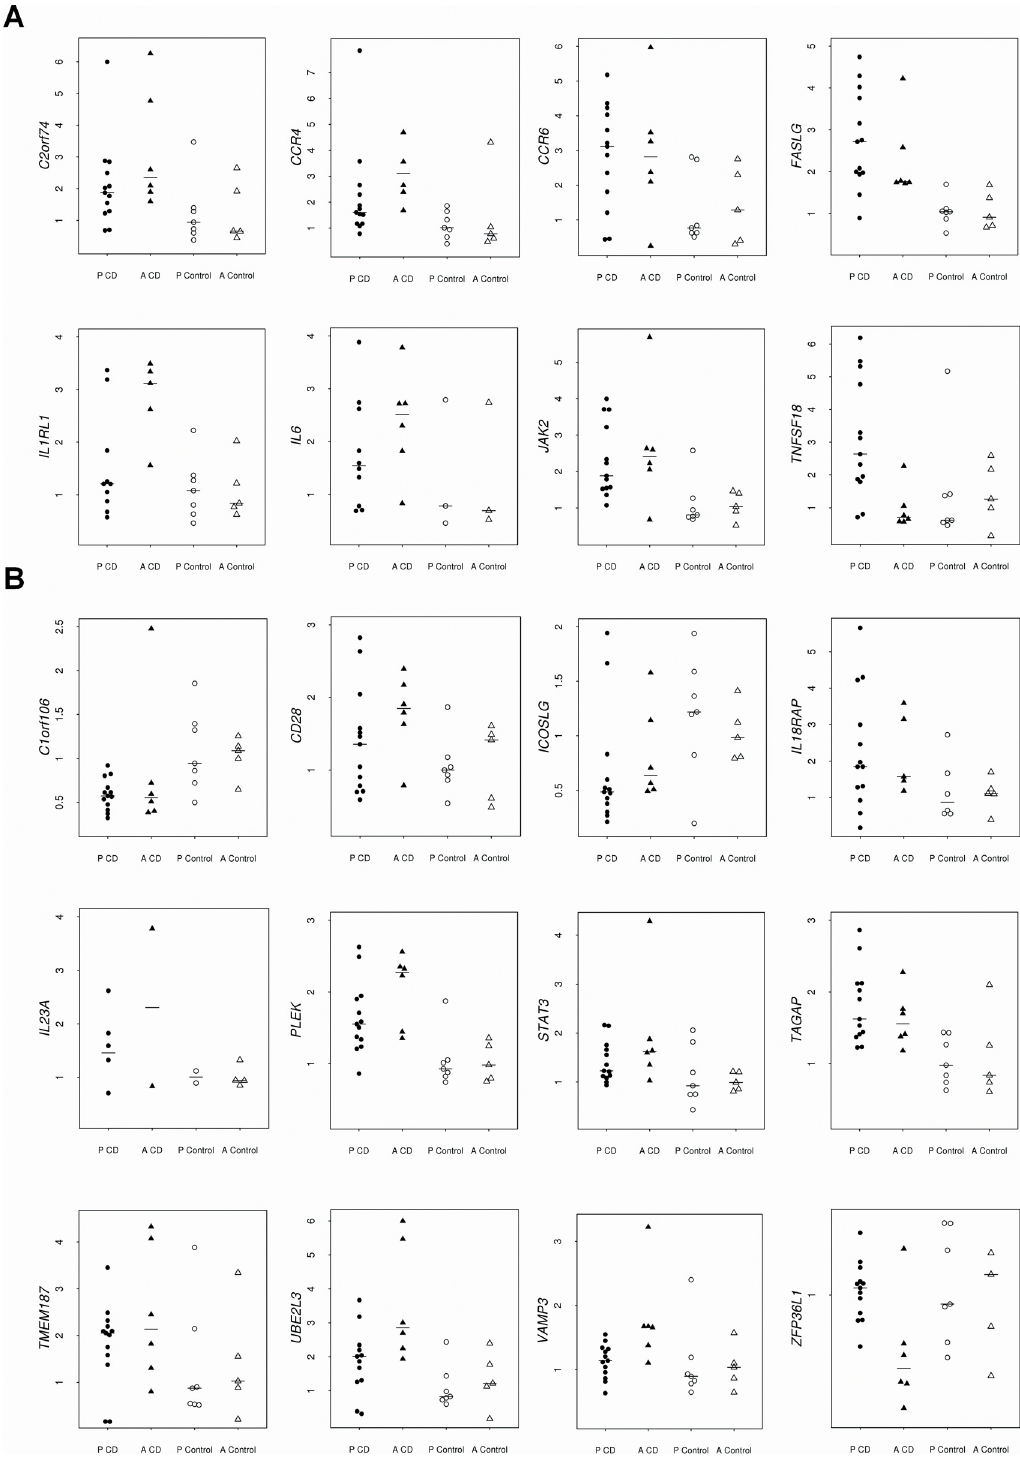
Fig 1. Relative expression in intestinal biopsies of children and adults with CD and non-CD control children and adults of the genes altered in at least one group of patients with A) high significance and B) low significance. Pediatric patients and controls are represented by black and white circles, respectively; and adult patients and controls are represented by black and white triangles,